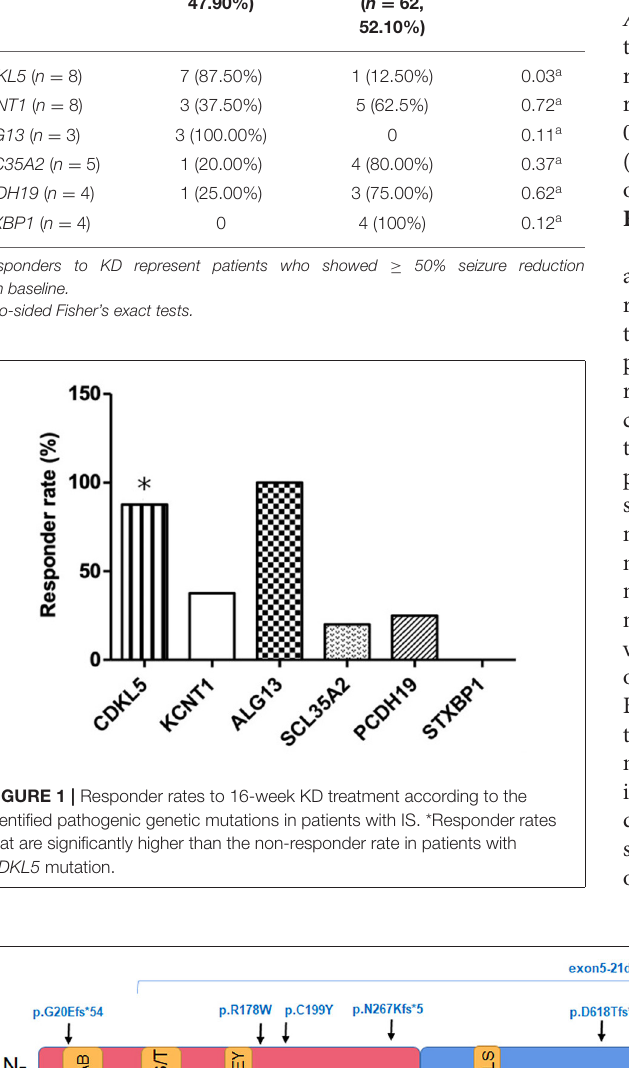
Frontiers in Pediatrics |